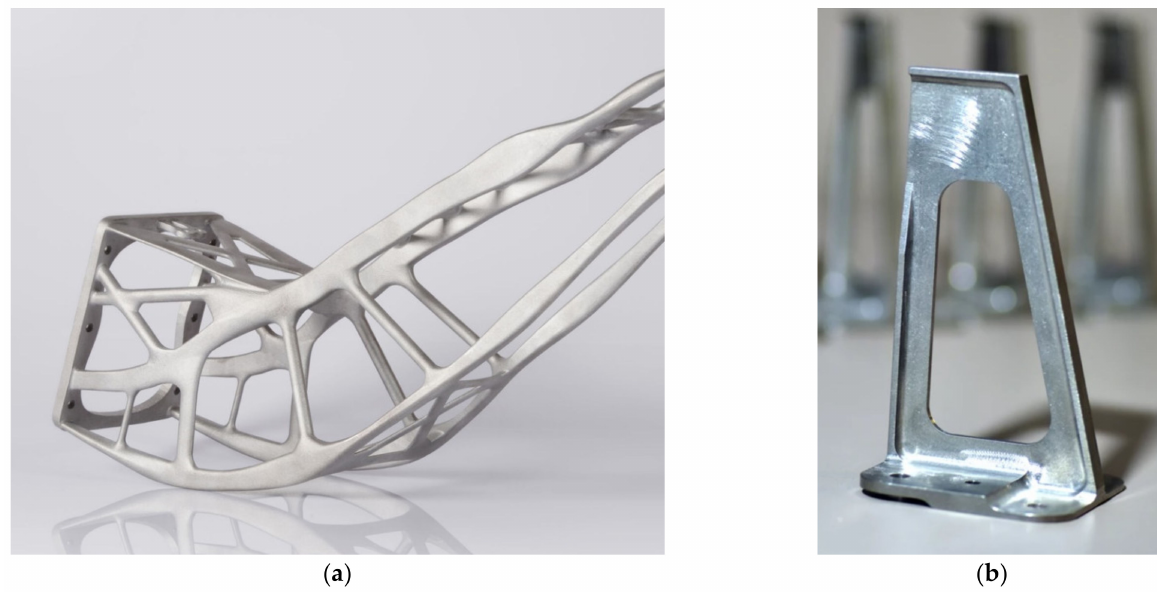
Figure 2. EOS and RUAG antenna bracket made of AlSi10Mg and manufactured by L-PBF ( a ) [34] (Image taken from https://www.eos.info/en/academic-info (accessed on 28 March 2023), Source: EOS GmbH); brackets mounted on Boeing 787 ( b ) [35] (Image courtesy of Spirit Aerosystems and pro- vided for an article by Additive Manufacturing Media: https://www.additivemanufacturing.media/ articles/what-is-the-role-for-additive-manufacturing-in-aircraft-structural-components (accessed on 28 March